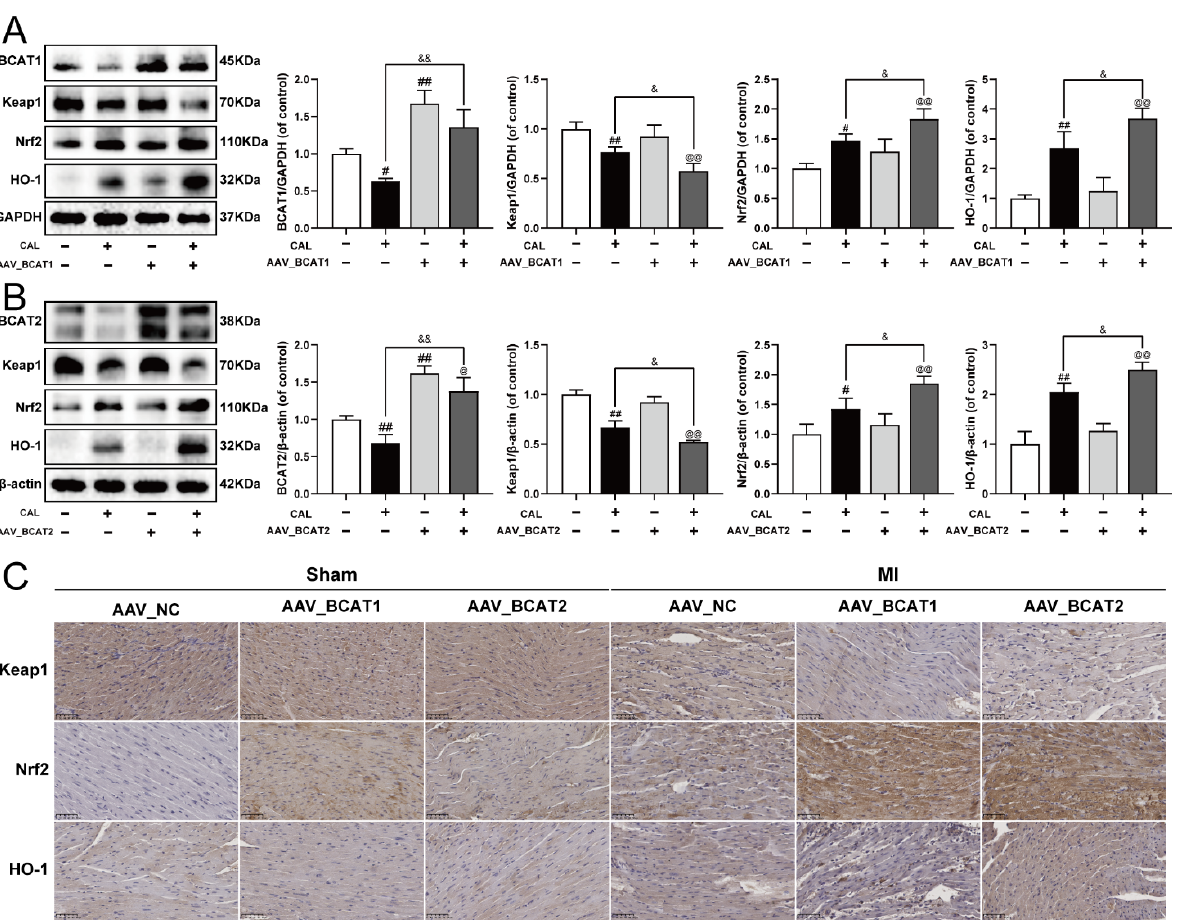
Figure 6. Cardiac overexpression of BCAT1 or BCAT2 activated the Keap1/Nrf2/HO-1 signaling pathway in MI mice. ( A ) Western blotting analysis of BCAT1, Keap1, Nrf2 and HO-1 in mice with cardiac overexpression of BCAT1 ( n = 3–4). ( B ) Western blotting analysis of BCAT2, Keap1, Nrf2 and HO-1 in mice with cardiac overexpression of BCAT2 ( n = 3–4). ( C ) Immunohistochemistry images of Keap1, Nrf2 and HO-1 in mice with cardiac overexpression of BCAT1 or BCAT2 (scale bar, 50 µm, n = 3). Results were expressed as mean ± SD. # p < 0.05, ## p < 0.01 vs. the sham group, & p < 0.05, && p < 0.01 vs. the MI group, @ p < 0.05, @@ p < 0.01 vs. the group treated with AAV-BCAT1 or AAV-BCAT2.